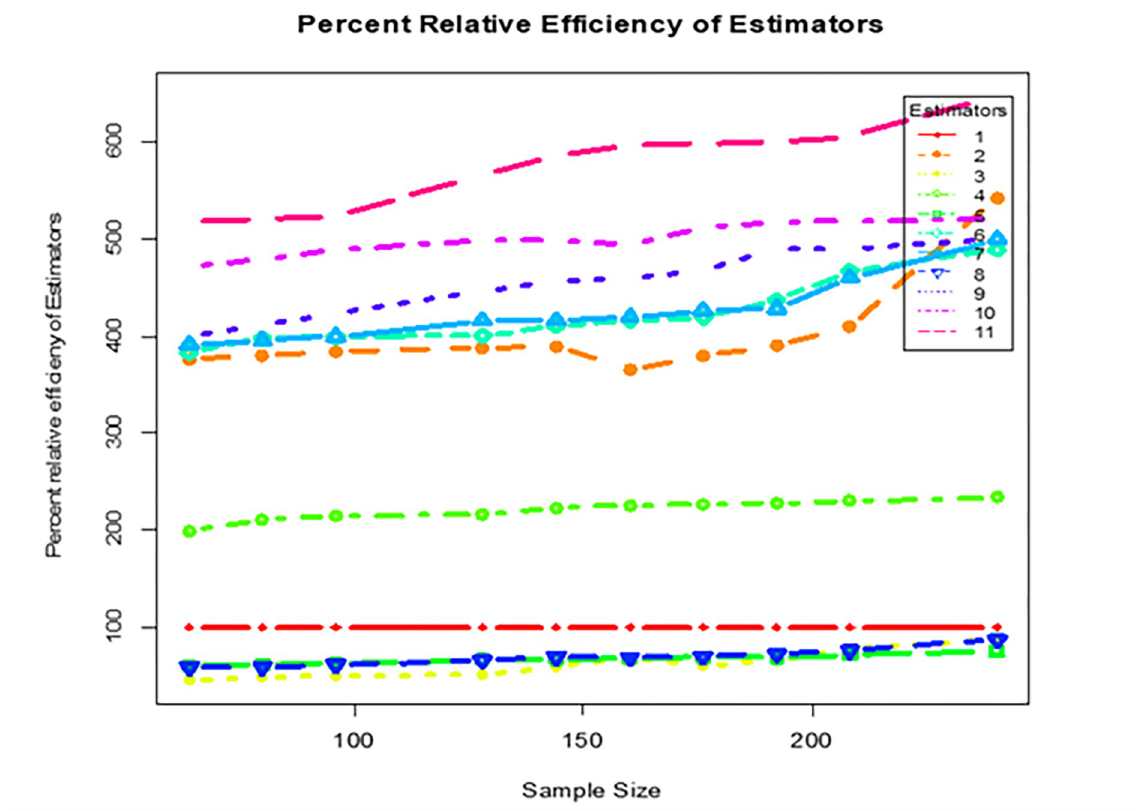
Fig 1. Percentage relative efficiency of different